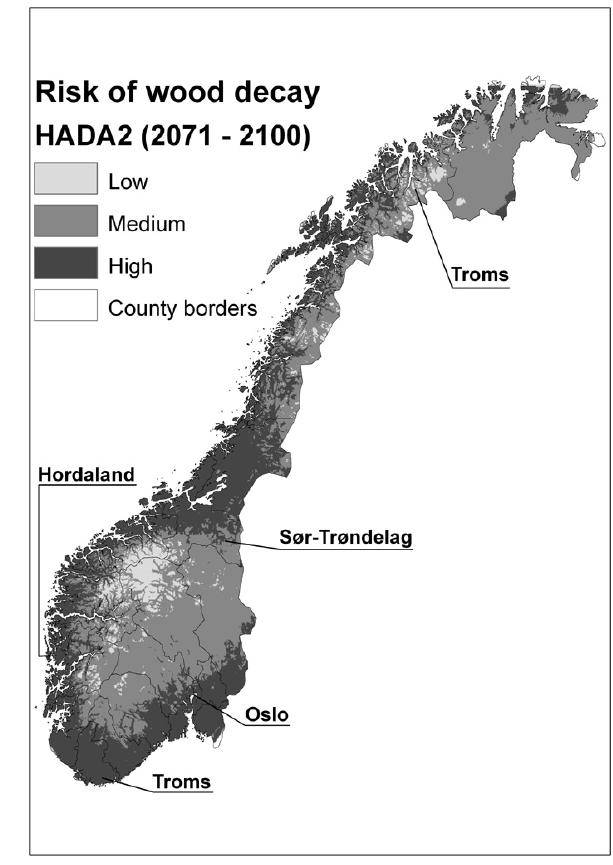
Figure 2. Map of Norway classified in risk of wood decay in future climate, based on projections by the Hadley Centre and scenario A2. Counties selected in Table 1 are